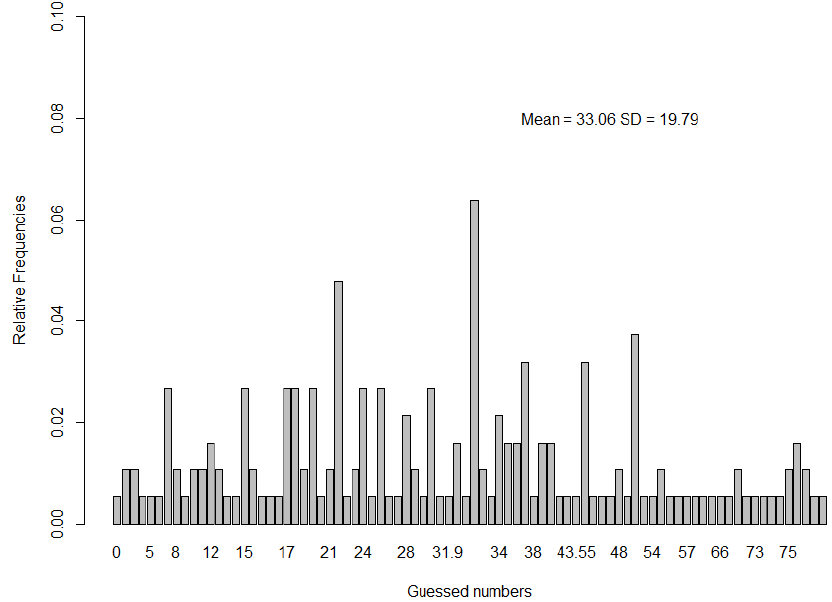
Figure 1. Distribution of guessed numbers.